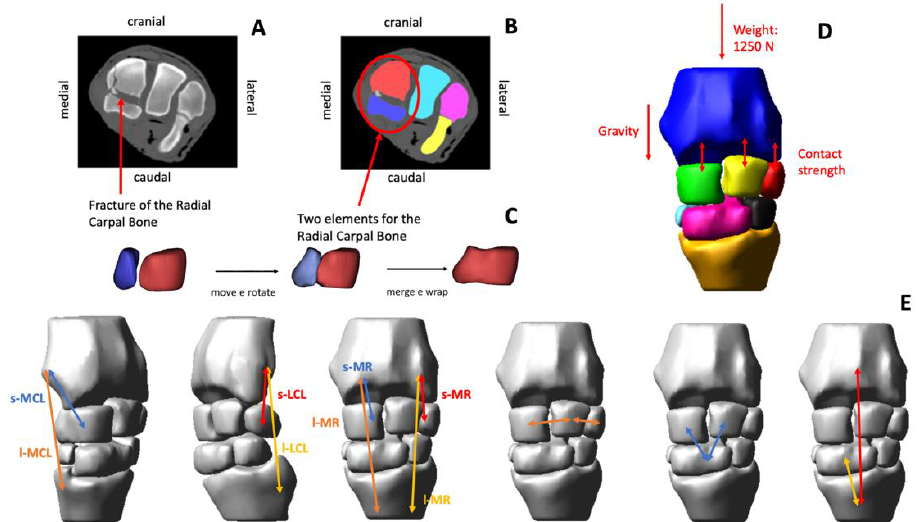
Figure 1. Workflow used to build a simplified equine carpus model ( A – E ). The radial carpal bone (Cr) was fractured into two main pieces ( A ). The fractured volumes of the Cr were segmented ( B ). The Cr was virtually reconstructed by aligning the bone fragments and applying a wrapping function to reproduce the non-fractured bone surface ( C ). All the articulating bones of the carpal joint were segmented, and the respective three-dimensional (3D) solid geometries were created using software for 3D image processing. The 3D model was imported in multibody software and the gravity, and the weight forces were introduced ( D ). The collateral ligaments and the dorsal retinaculum were modelled ( E ). The short and long medial collateral ligaments (s-MCL and l-MCL), and the short and long lateral collateral ligaments (s-LCL and l-LCL) were introduced in the model. The short and long medial retinaculum (s-MR and l-MR) blended with the dorsal joint capsule and fascia were modelled. The intercarpal ligaments were modelled as bushing elements, acting between two bones proportionally to their relative linear and angular displacements and velocities.